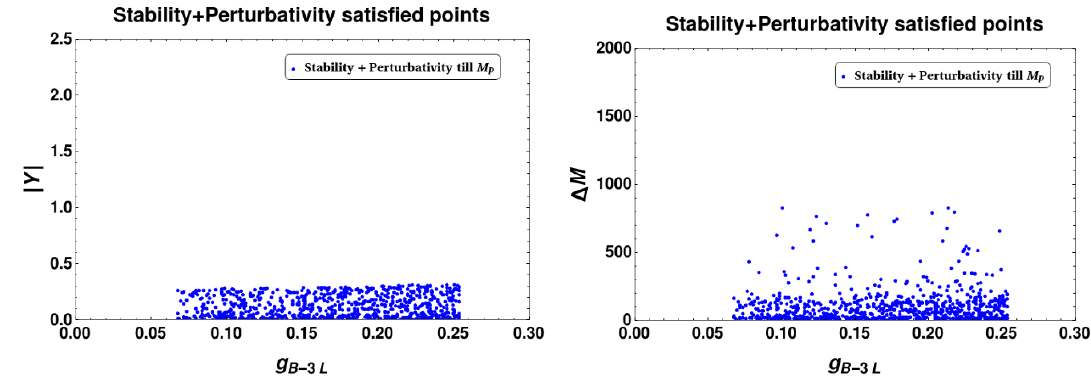
Figure 10 . Parameter space satisfying DM relic abundance, direct detection, perturbativity and vacuum stability (till M P ) bounds in (left) Y (cid:0) g B (cid:0) 3 L